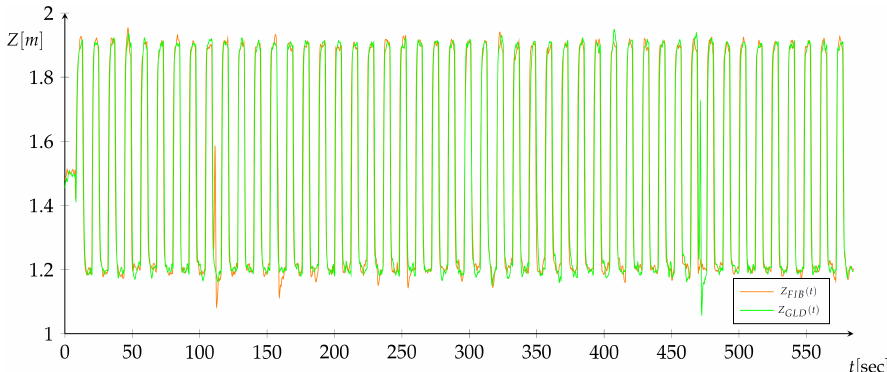
Figure 13. Values of J ( i ) in consecutive steps (i) of GLD and FIB